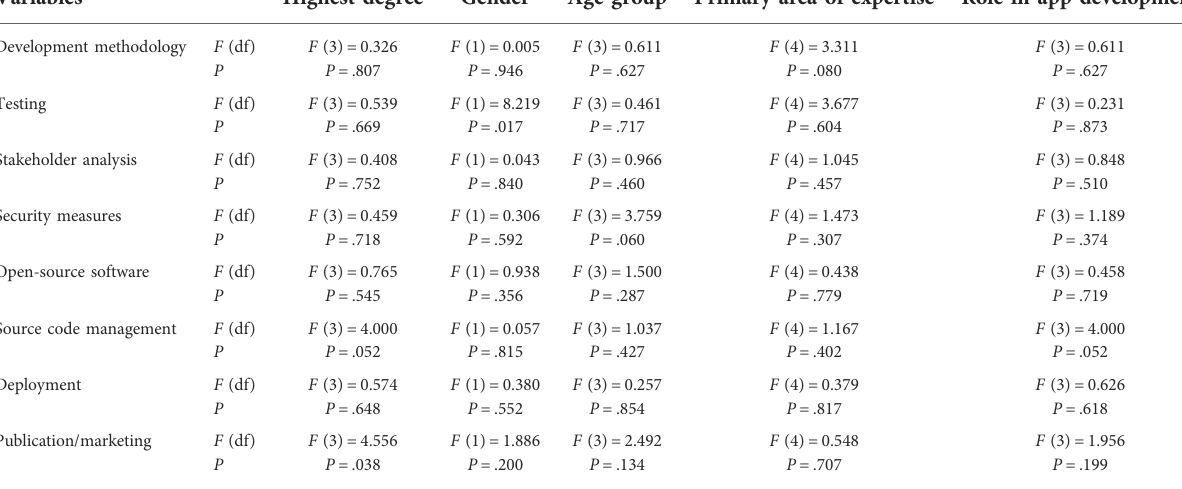
TABLE 6 Results of one-factorial